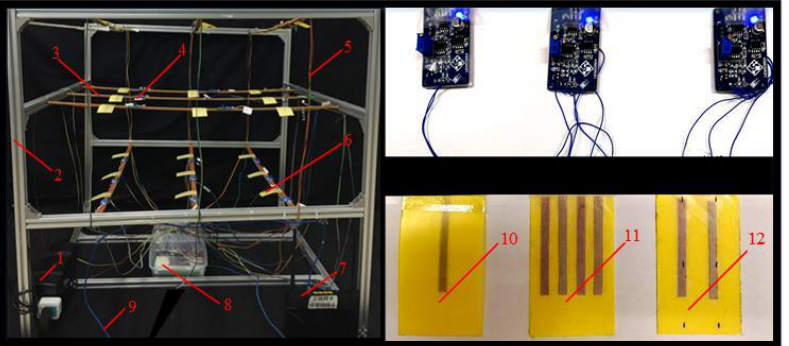
( b ) Figure 9. Test arrangement of test platform for rotorcraft UAV and flexible detection structure